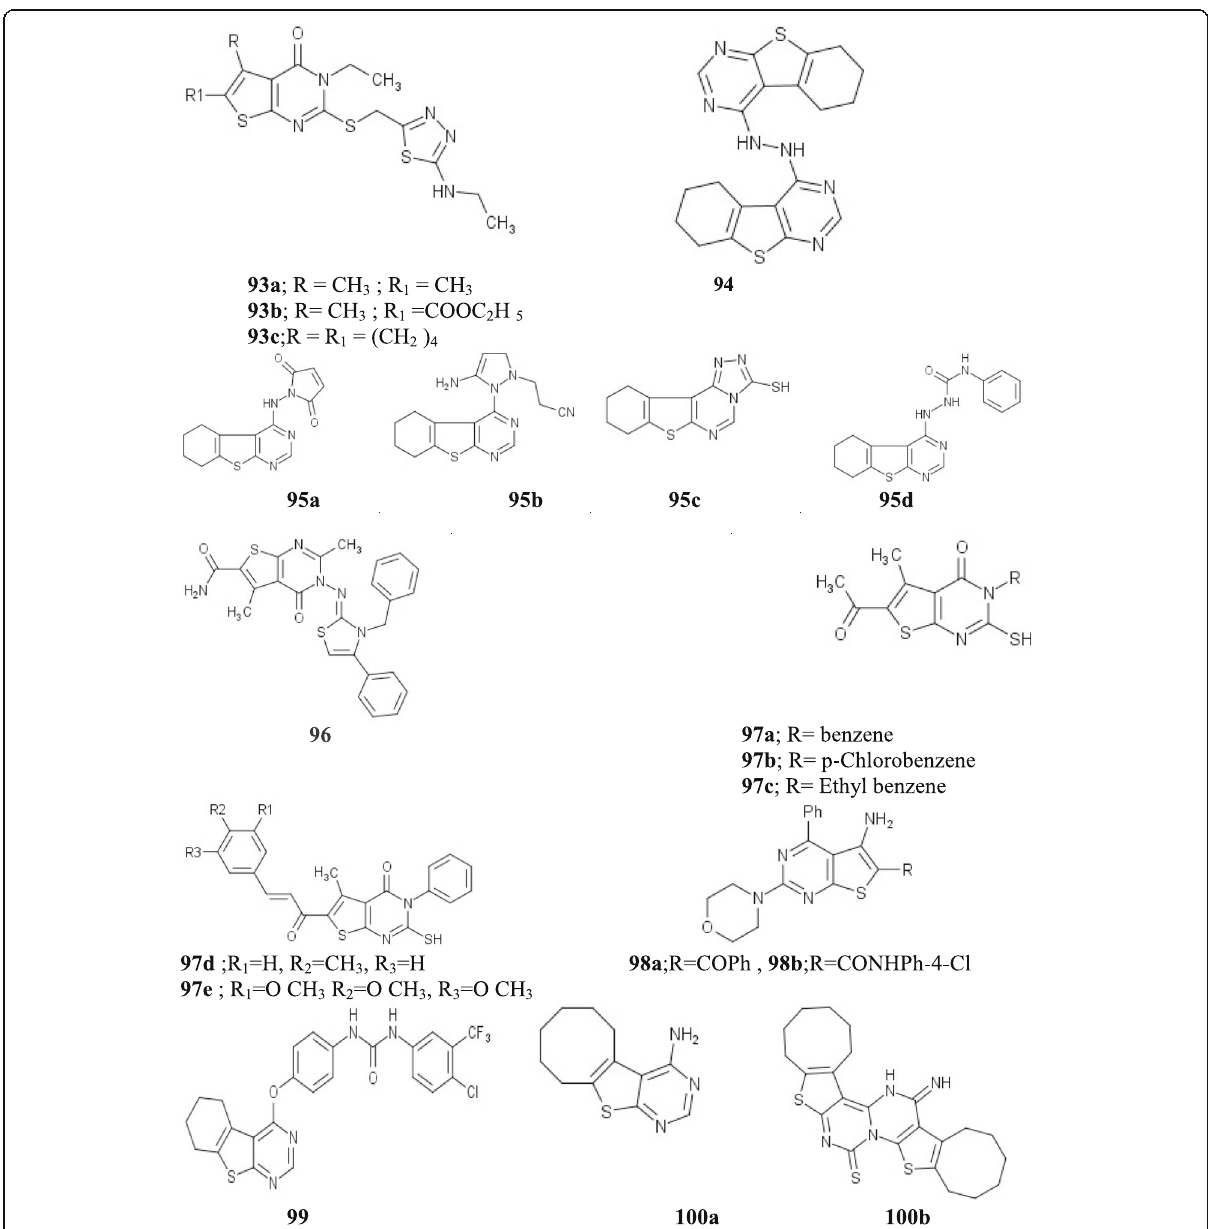
Fig. 33 Chemical structures of thieno pyrimidine